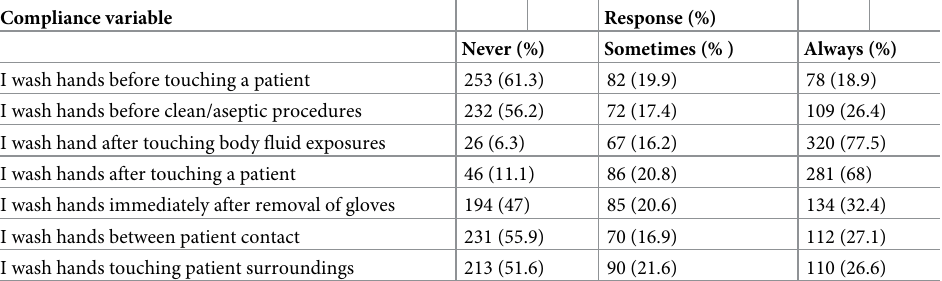
Table 1. Level of compliance with hand hygiene among healthcare workers of Hawassa comprehensive specialized hospital, 2019. Compliance